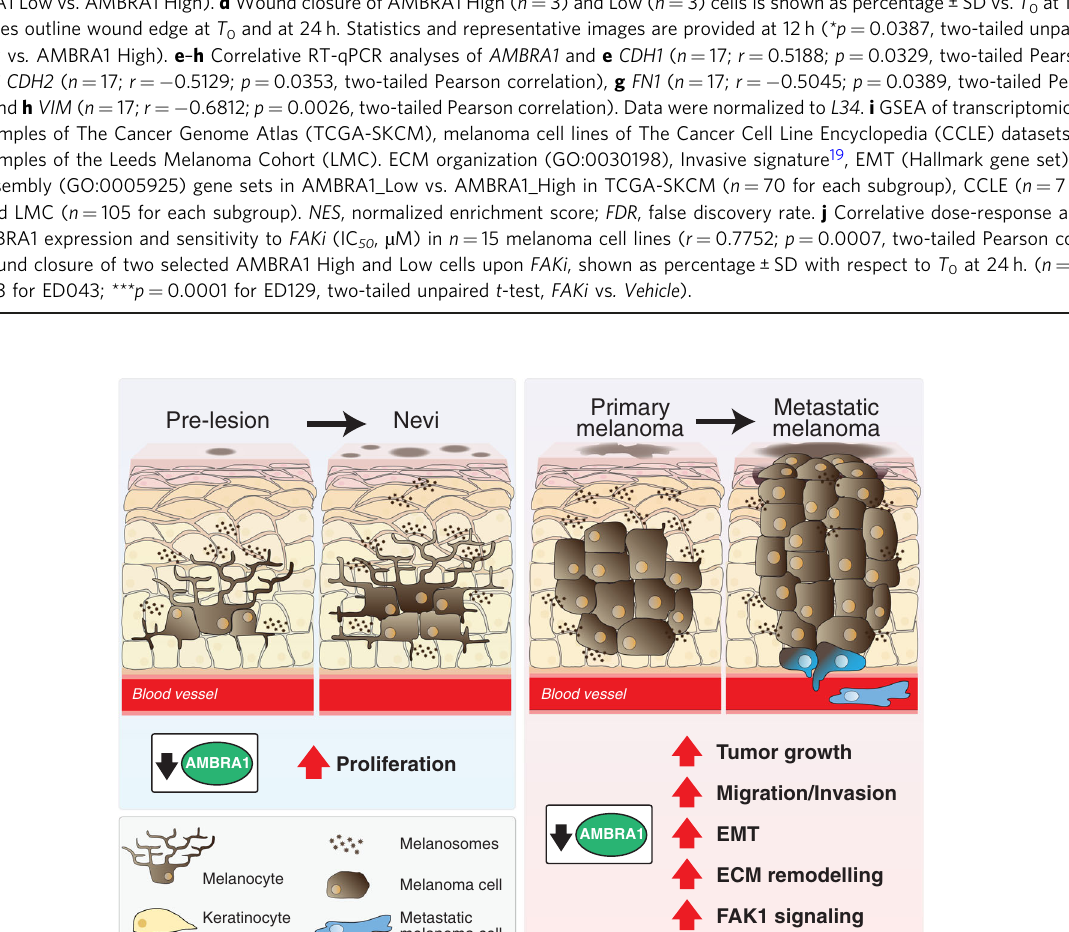
Fig. 6 Low AMBRA1 expression in human melanoma correlates with invasive gene signature and sensitivity to FAKi. a WB analyses of AMBRA1 in lysates from 17 melanoma cell lines. Actin was used as a loading control. Image is representative of n = 3 gels. b AMBRA1 High and Low groups were determined by densitometric analyses of AMBRA1, expressed as AMBRA1/Actin ratio ± SD ( n = 3; ****p < 0.0001 , two-tailed unpaired t -test). c Count of migrating AMBRA1 High ( n = 3) and Low ( n = 3) cells. Data are expressed as mean ± SD and images representative ( **p = 0.0026, two-tailed unpaired t -test, AMBRA1 Low vs. AMBRA1 High). d Wound closure of AMBRA1 High ( n = 3) and Low ( n = 3) cells is shown as percentage± SD vs. T 0 at 12 h. White and yellow lines outline wound edge at T 0 and at 24 h. Statistics and representative images are provided at 12 h ( *p = 0.0387, two-tailed unpaired t -test, AMBRA1 Low vs . AMBRA1 High). e – h Correlative RT-qPCR analyses of AMBRA1 and e CDH1 ( n = 17; r = 0.5188; p = 0.0329, two-tailed Pearson correlation), f CDH2 ( n = 17; r = − 0.5129; p = 0.0353, two-tailed Pearson correlation), g FN1 ( n = 17; r = − 0.5045; p = 0.0389, two-tailed Pearson